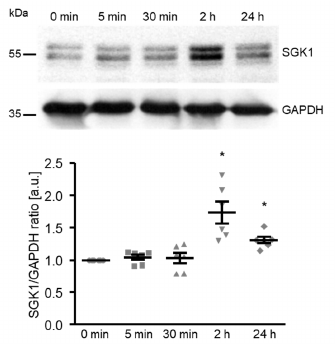
Figure 2. High glucose up-regulates the SGK1 protein abundance in HAoSMCs. Representative original Western blots and scatter dot plots and arithmetic means ± SEM ( n = 6; arbitrary units, a.u.) of the normalized SGK1 / GAPDH protein ratio in HAoSMCs following treatment for the indicated time (0–24 h) with 50 mM of glucose. * p < 0.05 significant vs. control